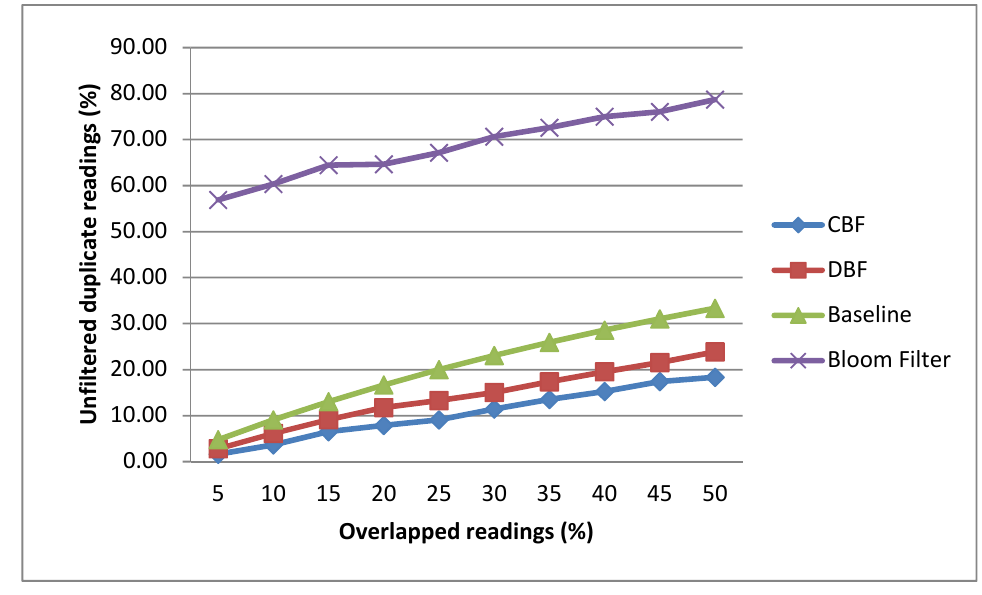
Figure 6. Percentage of unfiltered duplicate readings .